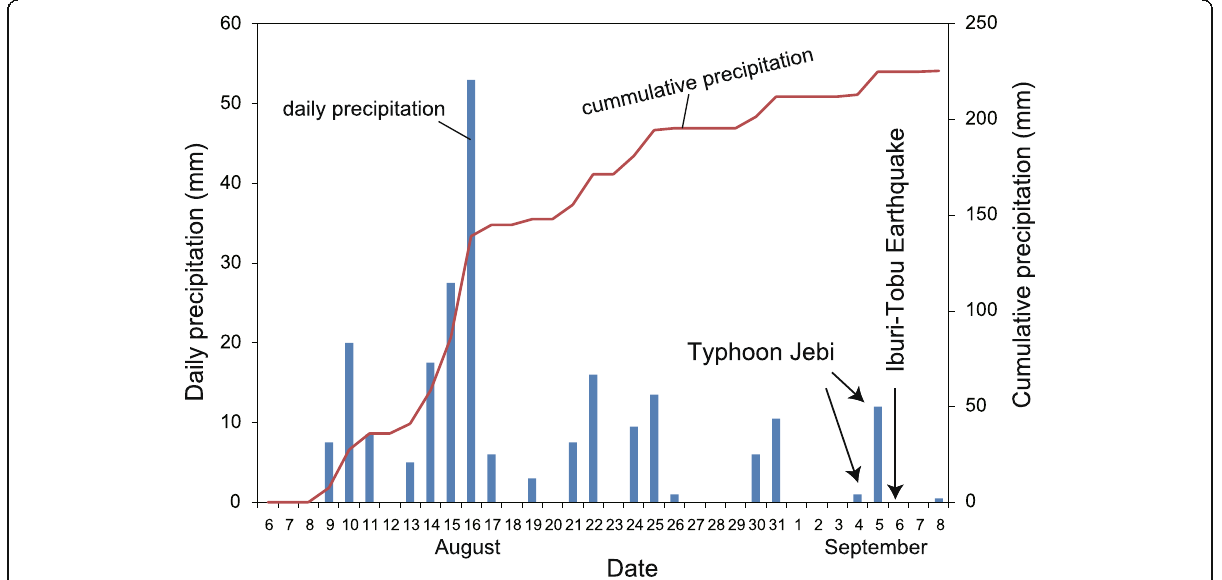
Fig. 2 Daily and cumulative precipitations observed at the Atsuma station (Japan Meteorological